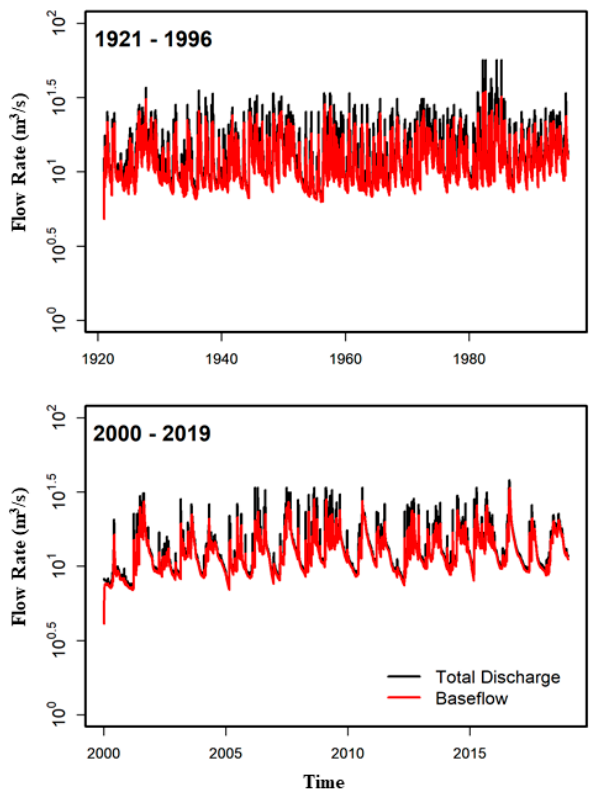
Figure 4. Separation of flow components for Big Spring over different time intervals using WHAT.